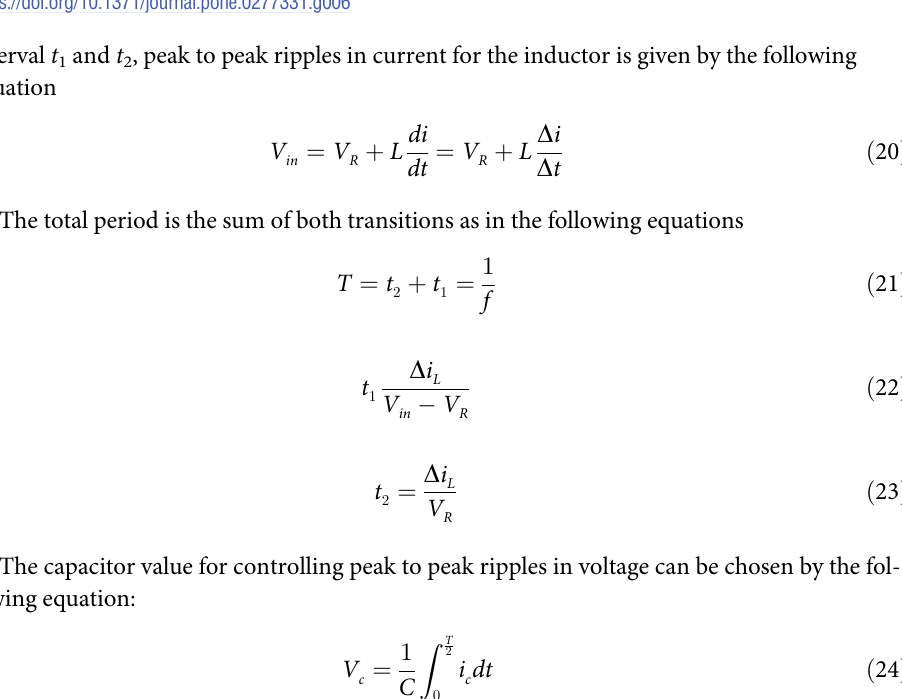
Fig 6. SiC NMOS Buck converter scheme includes (A) switch turns on (B) switch turns off and diode D conducts.